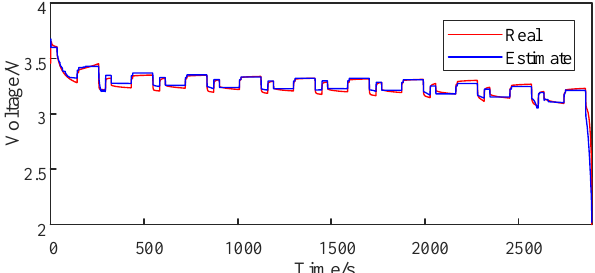
Figure 4. Comparison of model output value with real value.